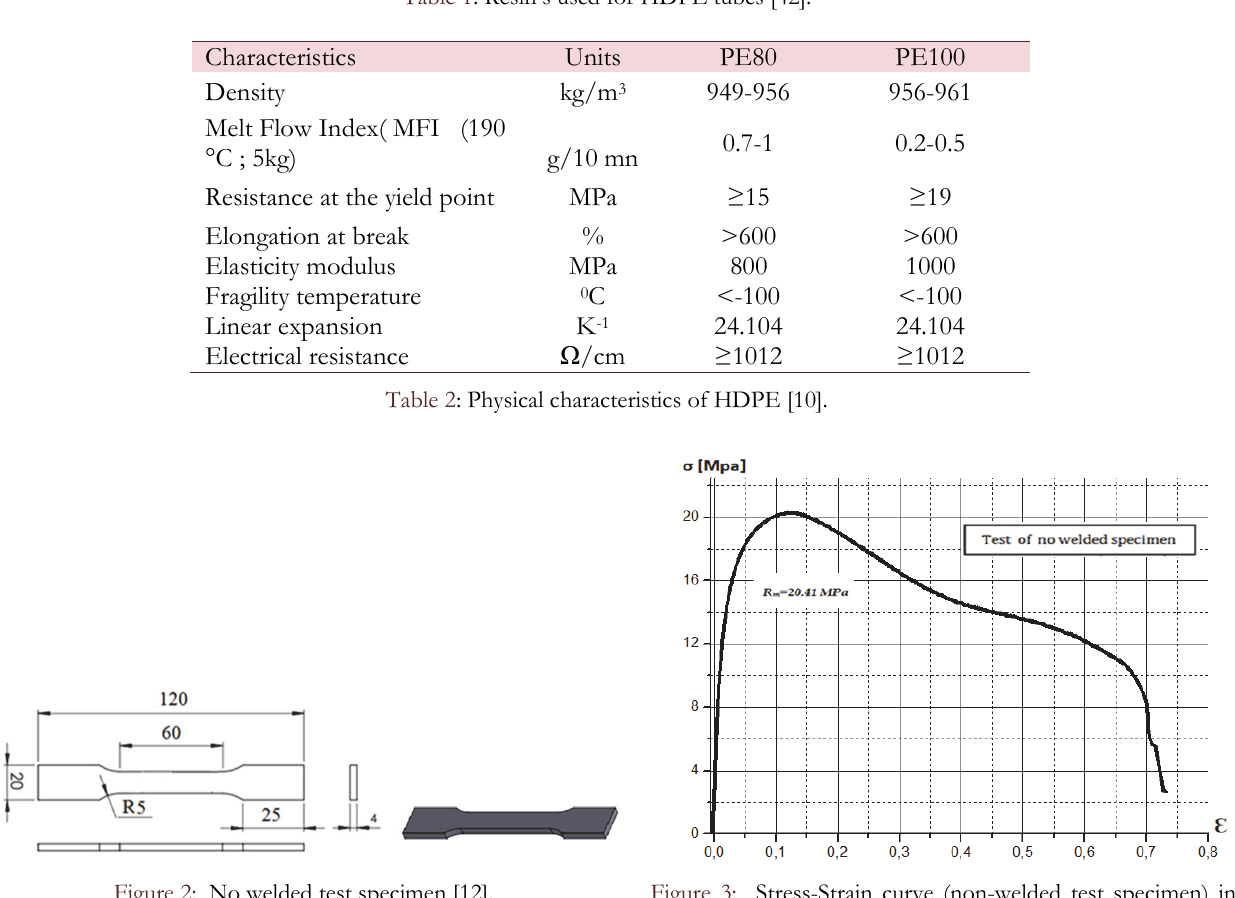
Table 1: Resin’s used for HDPE tubes [42].